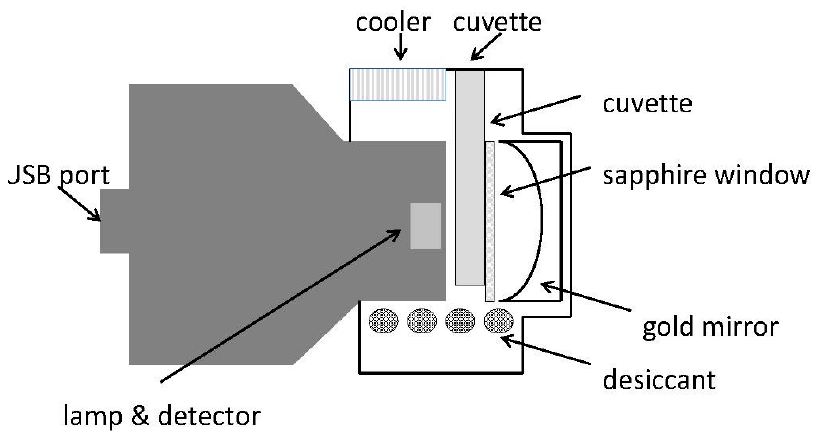
Figure 2. Enhanced detection system for a low-weight (<60 g) NIR probe [57].